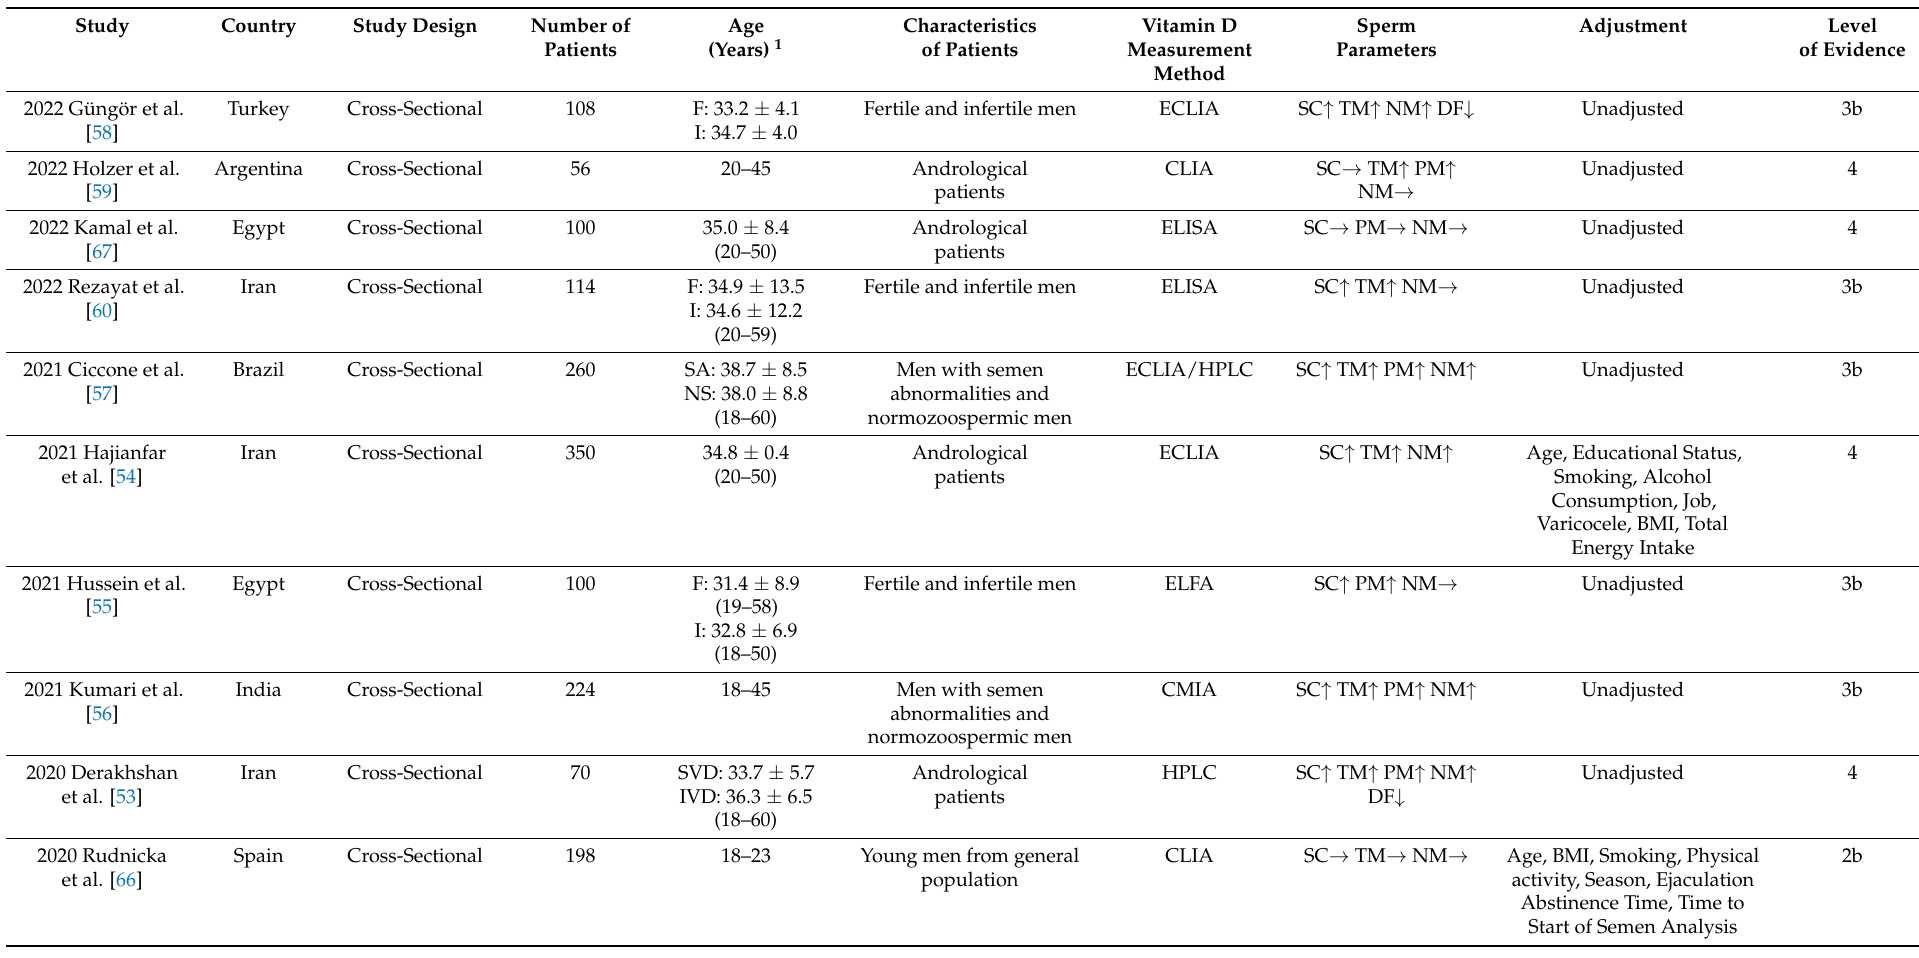
Table 1. Summary of Observational Studies between Vitamin D and Semen Quality Parameters in